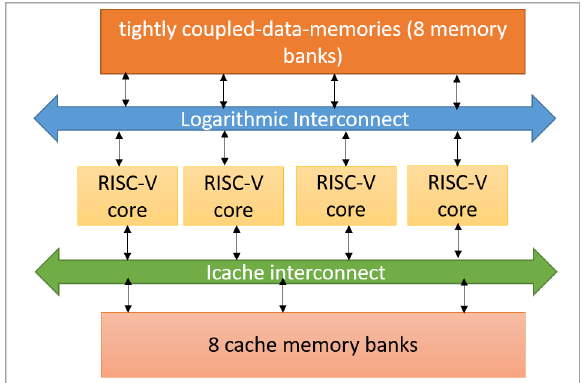
Figure 4. The PULP cluster with four cores in